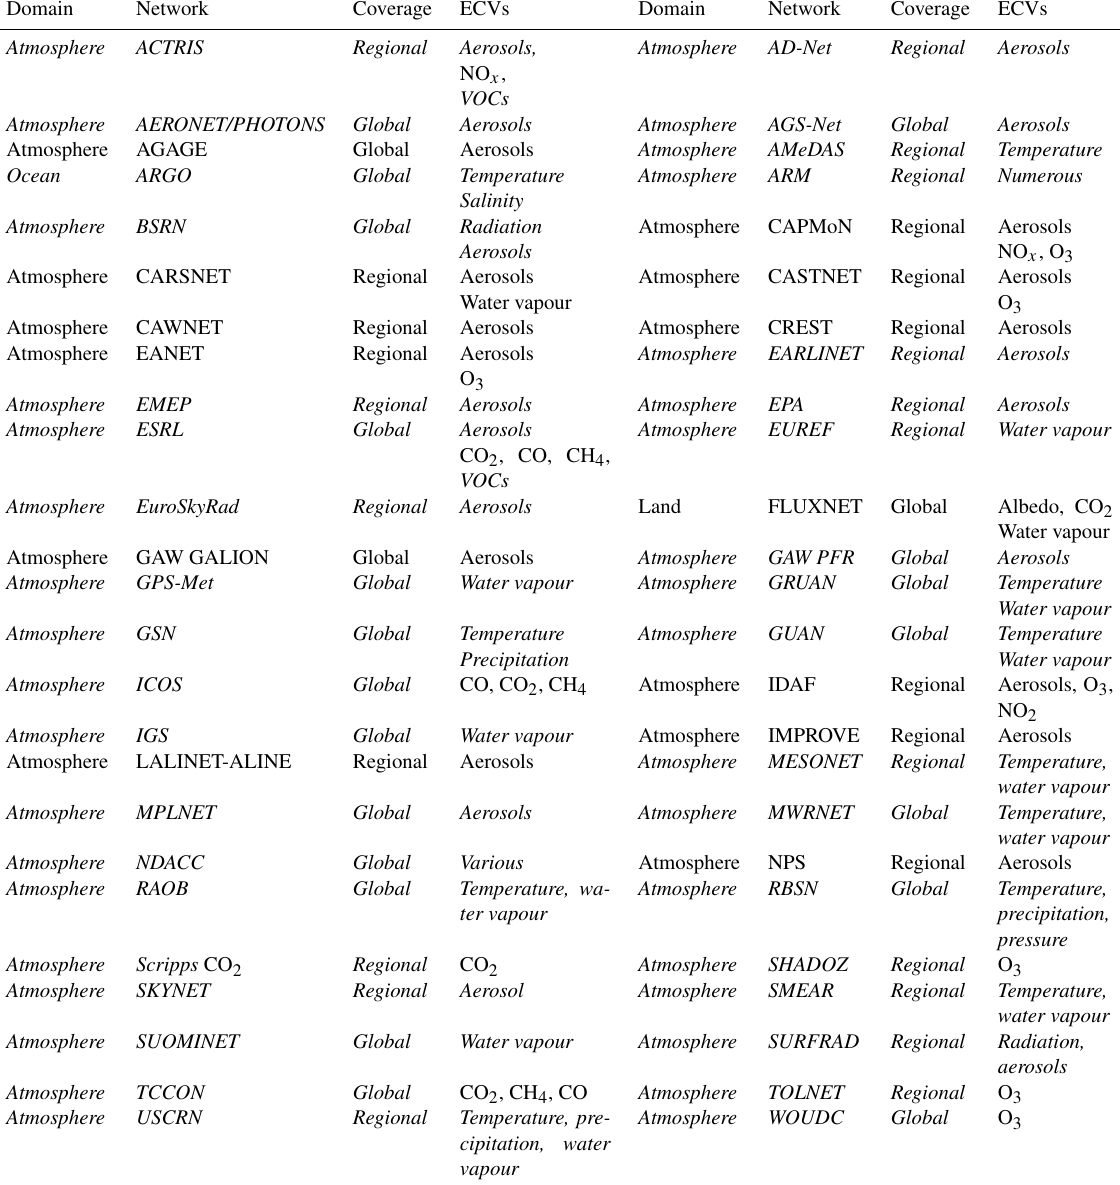
Table A1. Table summarising pertinent details of those networks considered in Sect. 4, listing those 49 networks reviewed within GAIA– CLIM Task 1.2 for which complete discovery metadata have been collected. The first column reports the measurement domain, the second the network acronym, the third, the network coverage, and the fourth includes the number of measured ECVs (repeated for columns 5 to 8). Those for which maturity assessments were performed and which are discussed from Sect. 4.1 onwards are